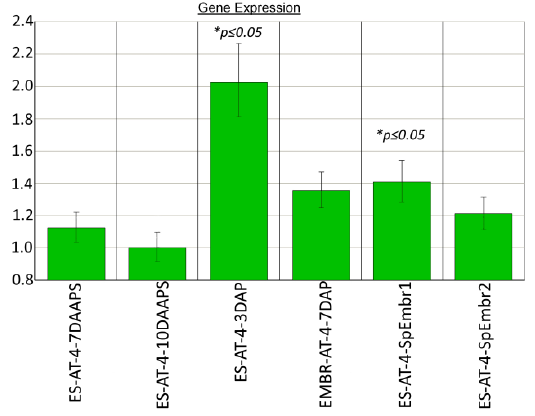
Figure 3. Chromatin-modulating factor ( chr106 ) expression in parthenogenic proembryos (10 DAAPS) and ESs (7 and 10 DAAPS) of the AT-4 line. Control: ESs at 10 DAAPS. ES-AT-4-7-10DAAPS: in one independent biological experiment, each sample consisted of 12 unpollinated ESs. Data are from four independent biological experiments.